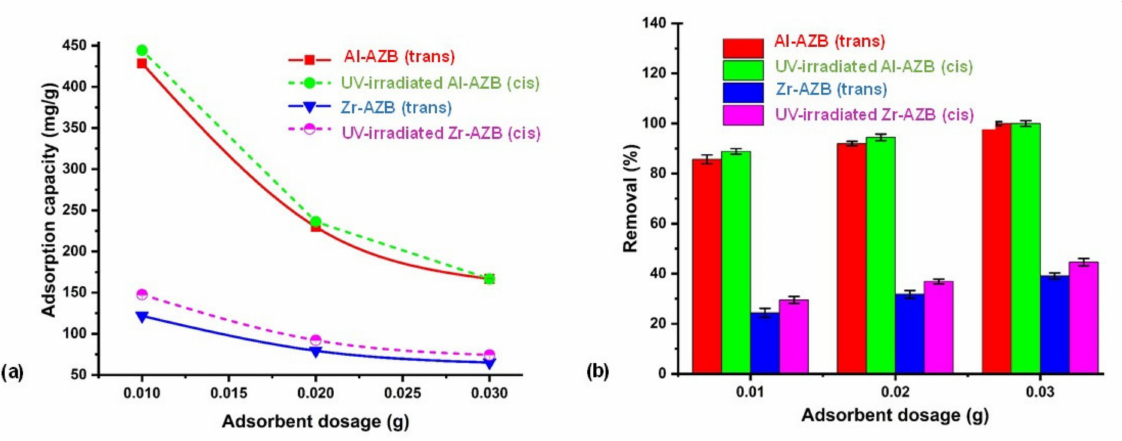
Figure 9. The effect of UV irradiation on the ( a ) adsorption capacity and ( b ) percentage removal of the metal organic frameworks at varying sorbent doses (pH 4.0, time 1440 min, temperature 300 K, dye concentration 500